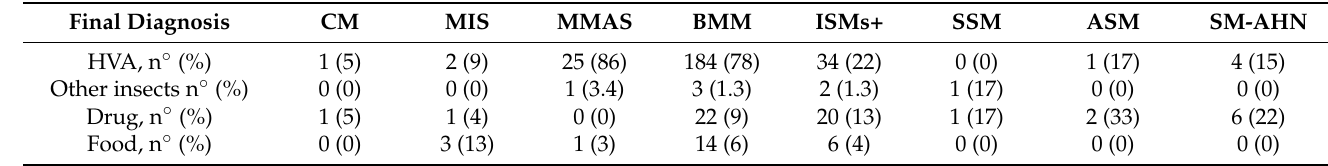
Table 3. Allergic reactions according to the diagnosis of clonal mast cell